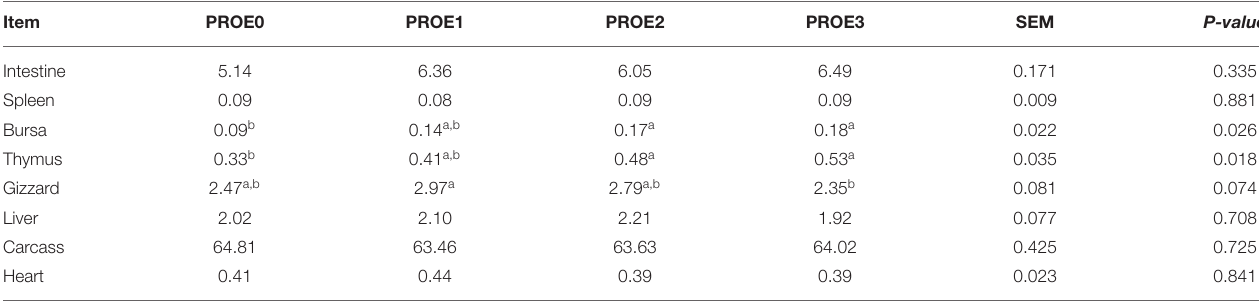
TABLE 4 | The effect of PROE supplementation on the carcass traits percentages relative to the live body weight. Item